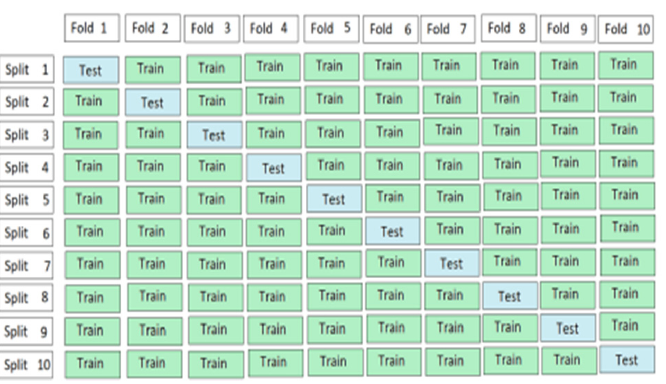
Figure 6. Working process of 10-fold cross-validation.